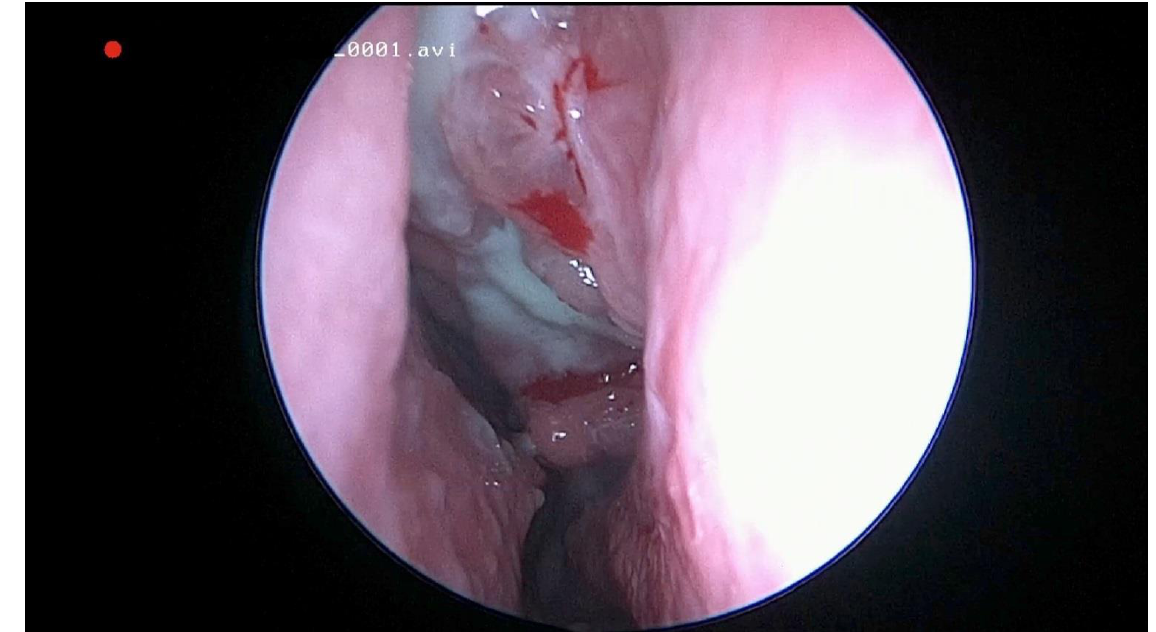
Figure 1. Endoscopic view of the left middle meatus with polypoid tissue and purulent drainage from the maxillary sinus in a patient with odontogenic sinusitis.